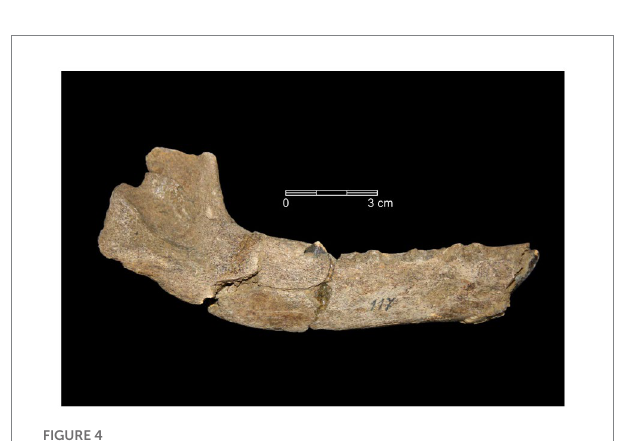
FIGURE 4 A right mandible from a large canid pup found at the Gravettian site of Předmostí (Czech Republic) that died when it was 4–5 months old (Germonpré et al., 2021a). The specimen is housed in the Moravian Museum, Brno (image credit: M.